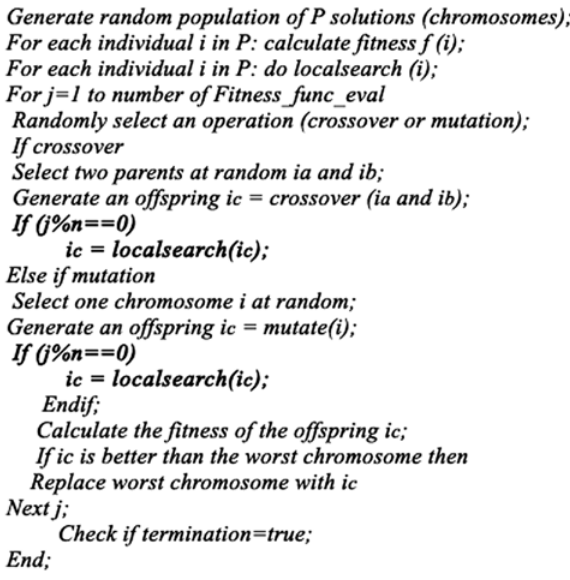
Figure 3: Pseudo-code for